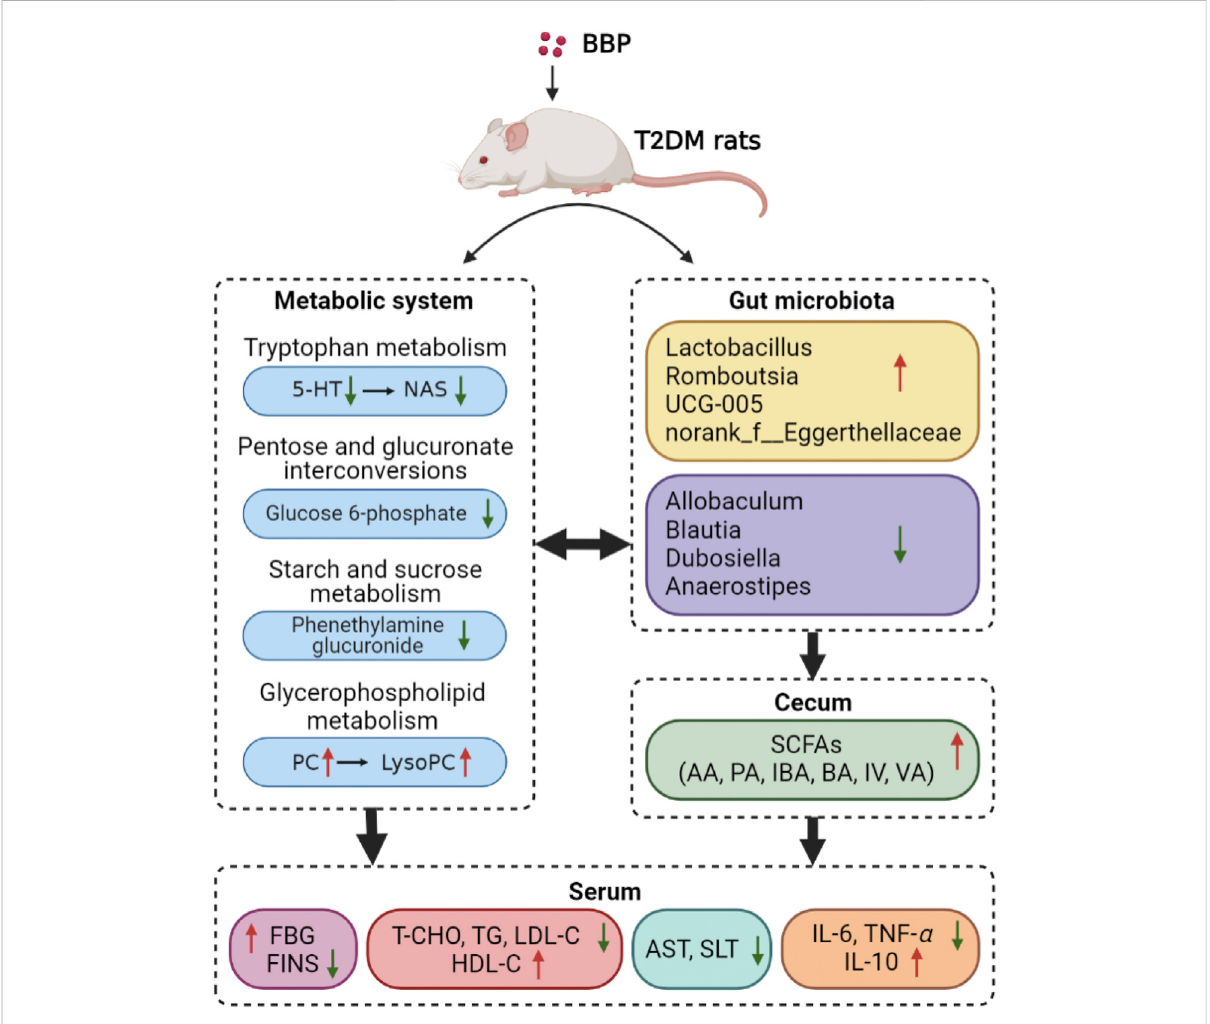
Mechanism of BBP in the treatment of T2DM rats by regulating metabolic pathway, IM composition and SCFAs level ( fi gure was created with